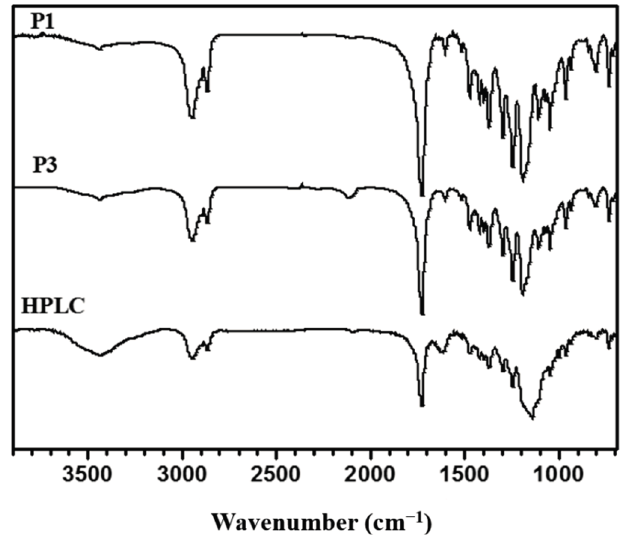
Figure 6. FT-IR spectra of the linear poly( ε -caprolactone) (P1, M n GPC = 7400 g/mol, M w / M n = 1.15), AB 2 macromonomer (P3) containing terminal ethyne and azide groups and hyperbranched poly( ε -caprolactone) (HPCL, M n GPC = 25,500 g/mol, M w / M n =